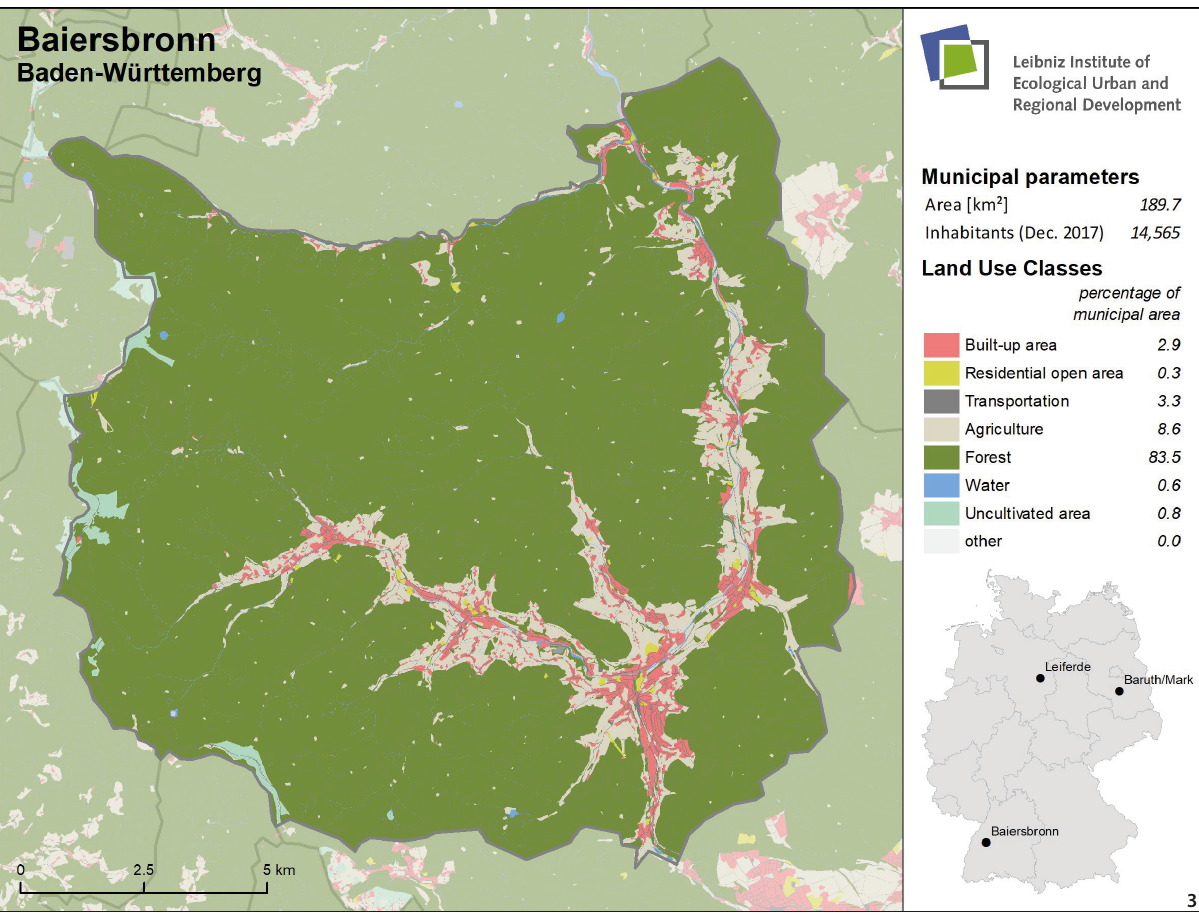
Figure 3 Land use in the rural municipality of Leiferde (Source: IOER Monitor 2019, Geobasis-DE/BKG